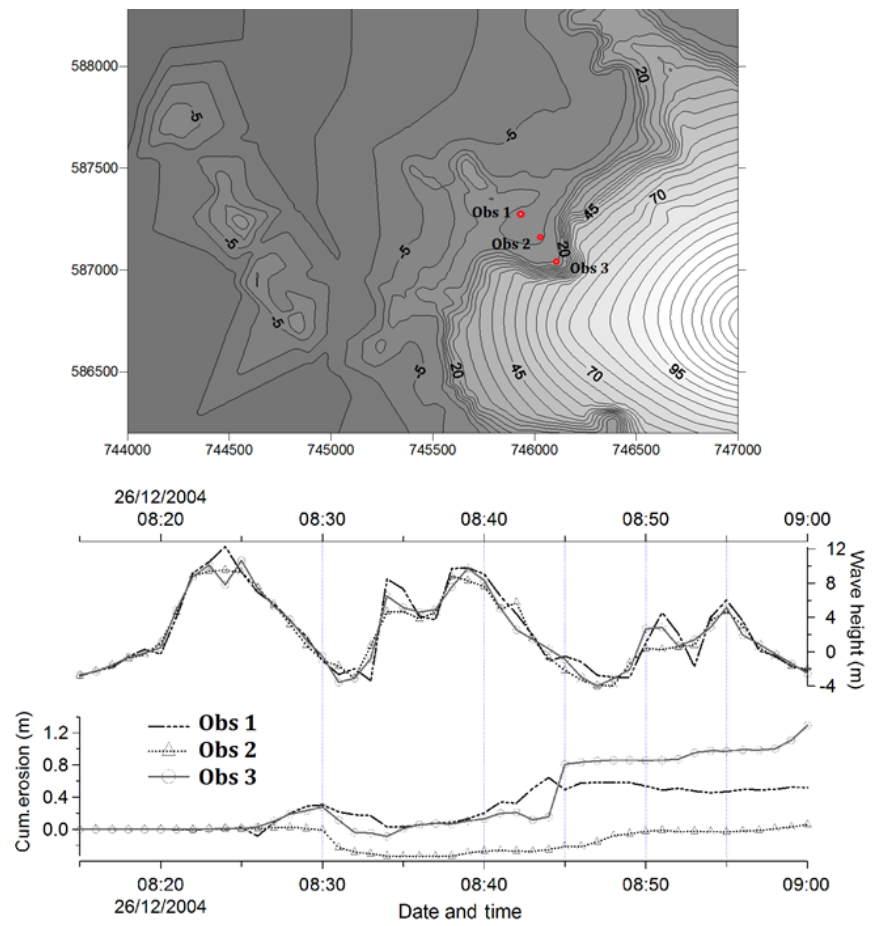
Figure 8. Relation between wave height and cumulative sediment on the observation points (shown in red